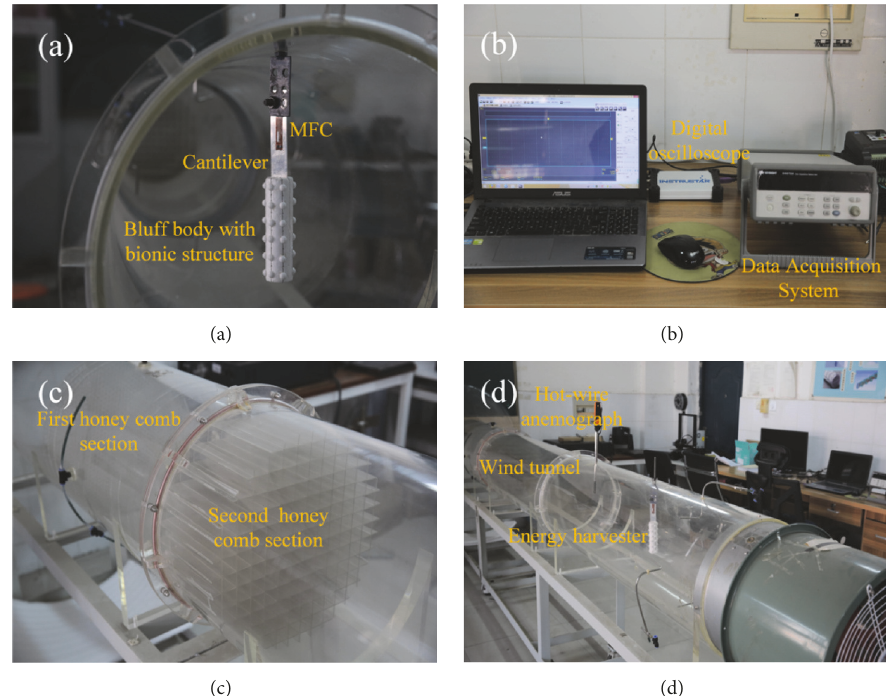
Figure 3: Entire experimental setup. (a) The fabricated energy harvester; (b) the data acquisition system; (c) honey comb for air stability; (d) the global views of the wind tunnel.